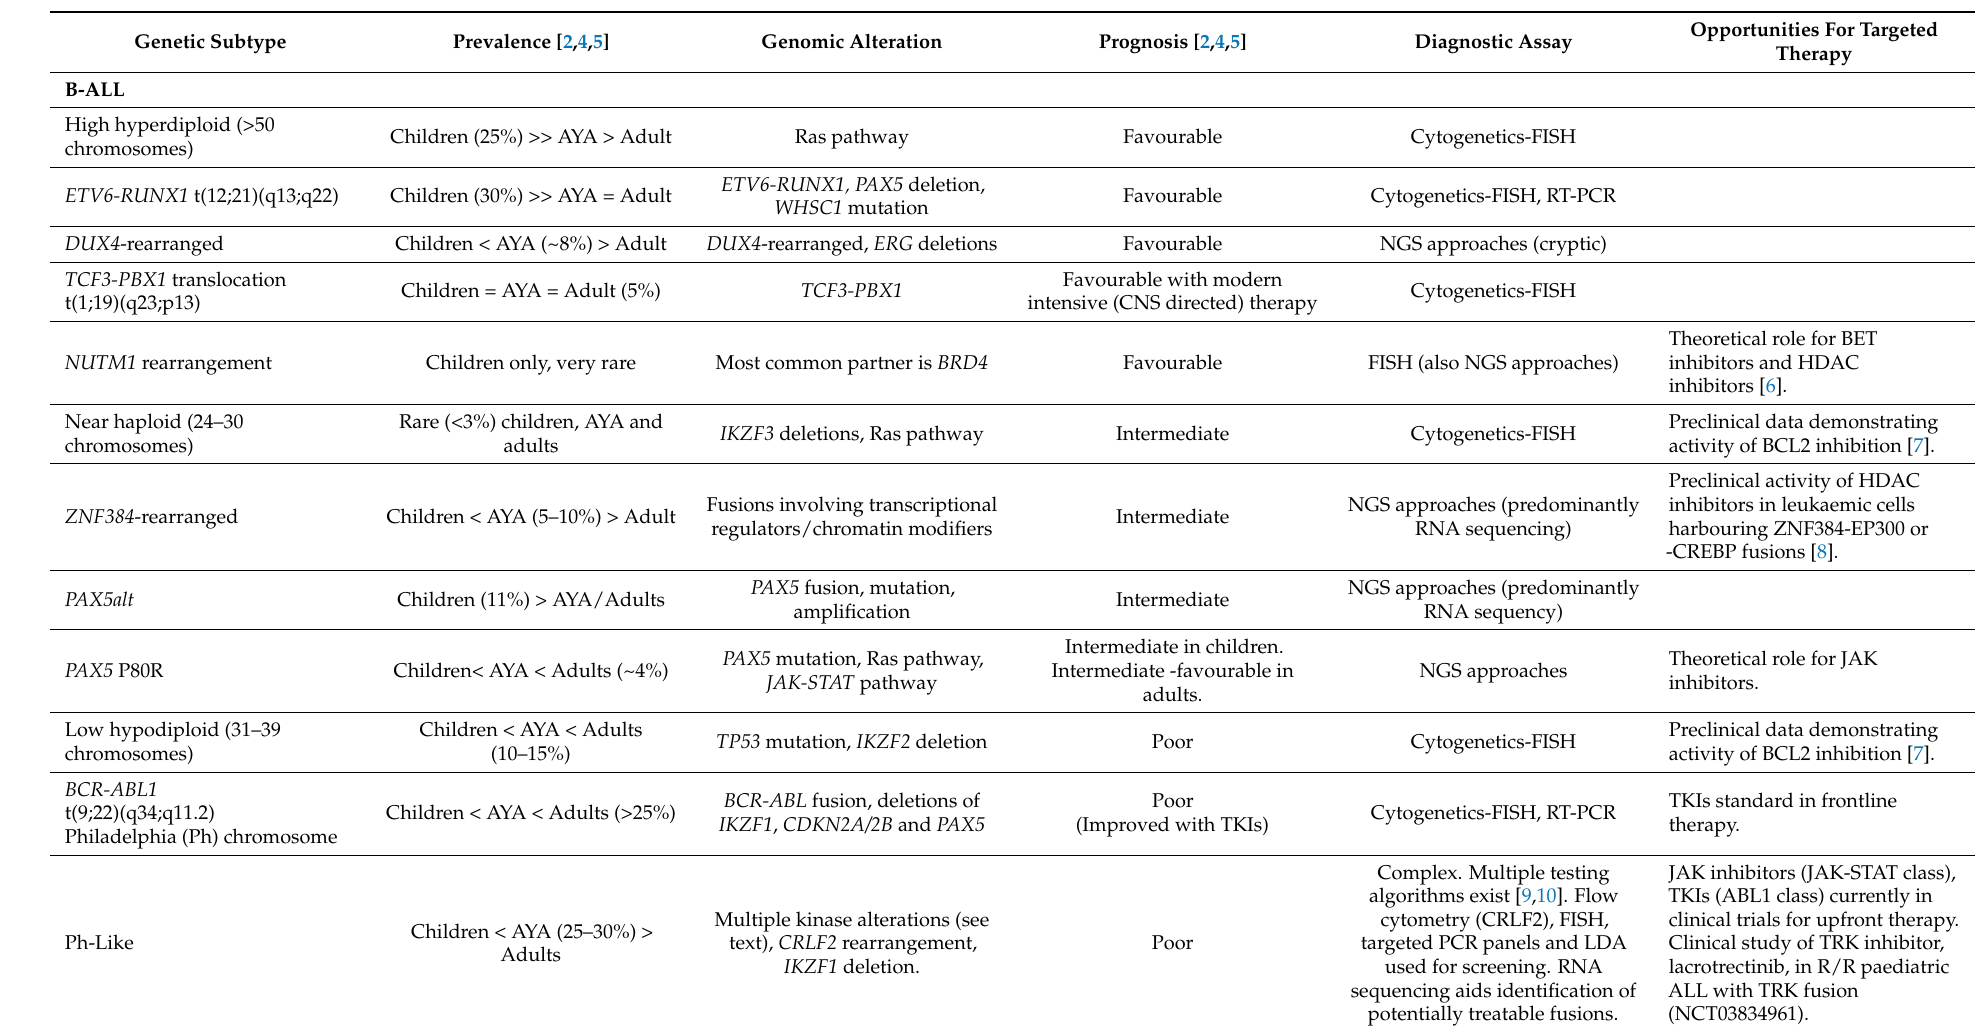
Table 1. Prognostic stratification in ALL based on standard cytogenetics/FISH and more recent molecular